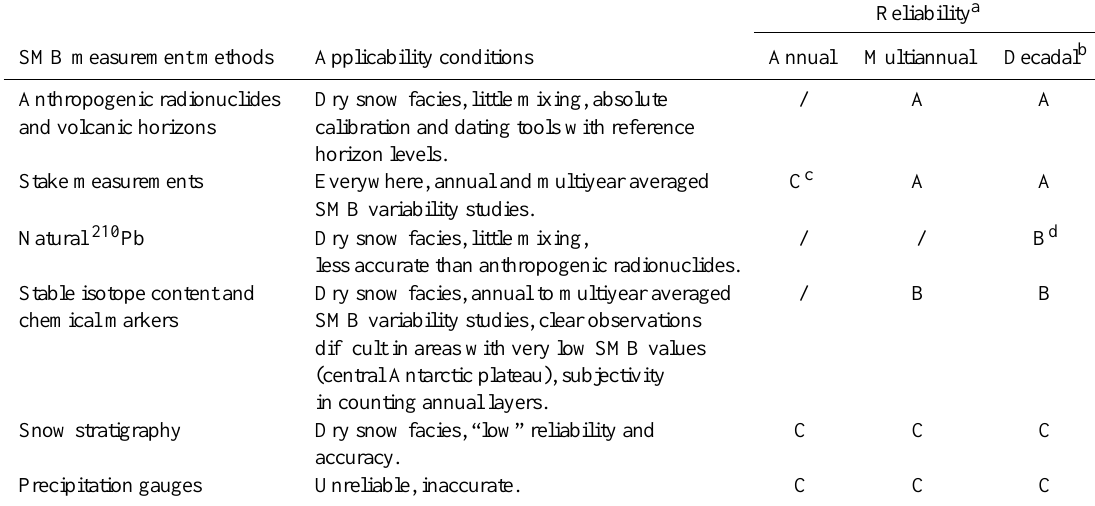
Table 3. Reliability and applicability conditions of SMB measurement methods (see Magand et al., 2007, for details on reliability criteria).